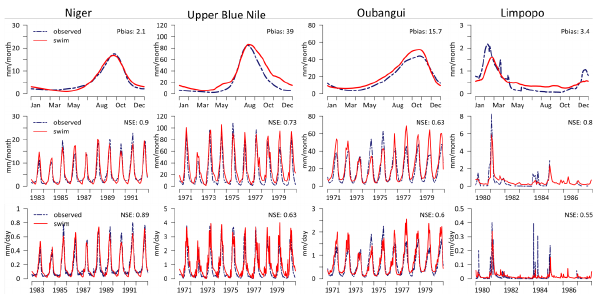
Figure 3 Validation of SWIM at the outlets of the four basins. In the top row the seasonality 2 Fig. 3. Validation of SWIM at the outlets of the four basins. In the of monthly runoff rate in validation period and PBIAS, in the middle row the monthly runoff 3 top row the seasonality of monthly runoff rate in validation period rate and in the bottom row the daily runoff rate in the validation period, both with Nash-4 and PBIAS, in the middle row the monthly runoff rate and in the Sutcliffe Efficiency. 5 bottom row the daily runoff rate in the validation period, both with Nash–Sutcliffe efficiency.